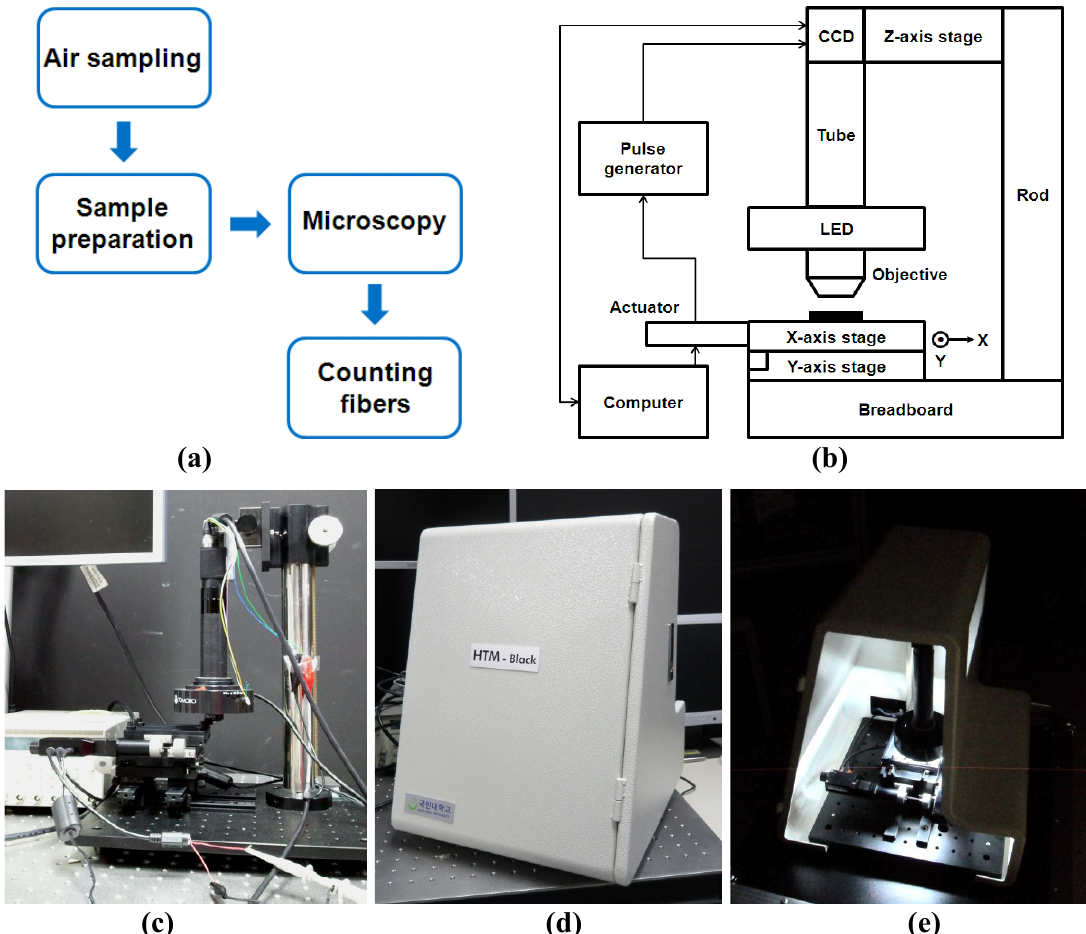
Figure 1. (a) Steps for conventional phase-contrast microscopy (PCM) method; (b) Schematic; and (c) photograph of setup for newly developed